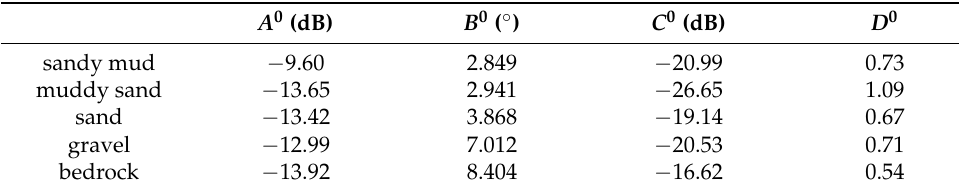
Figure 12. ARCs of various sediments. Table 4. The GSAB model parameters of various sediments.